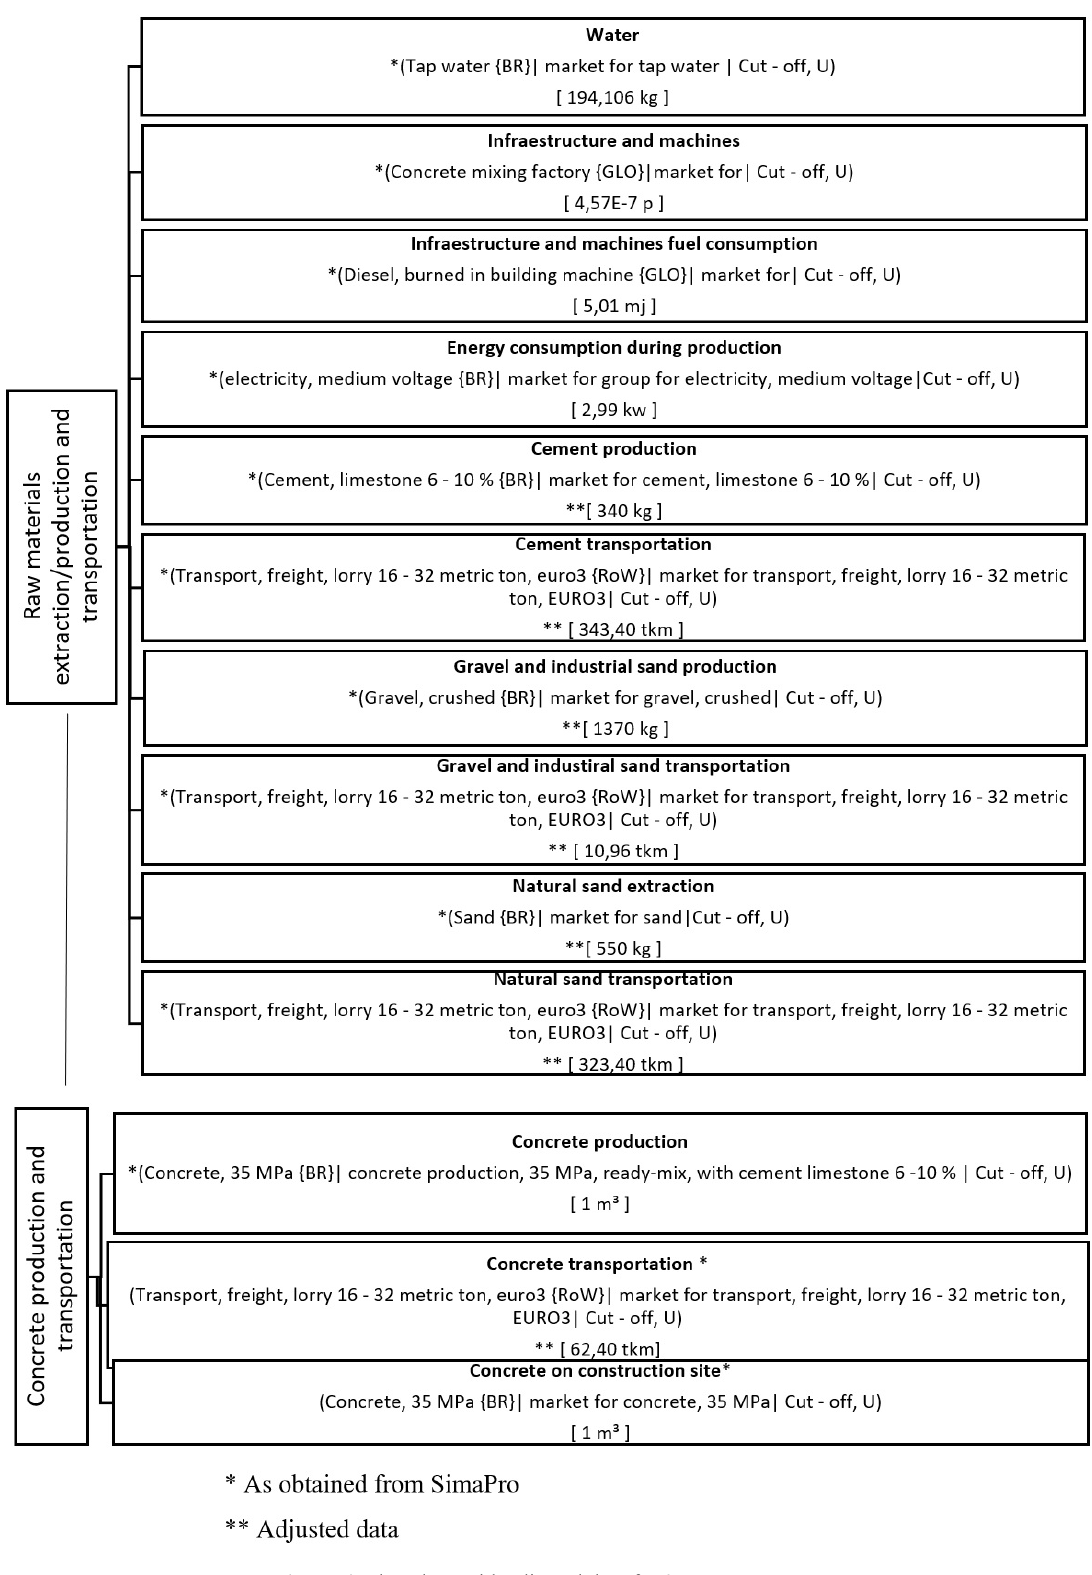
Figure 4. Flowchart with adjusted data for 35 MPa